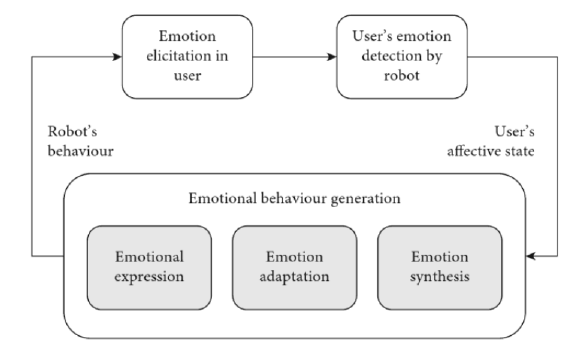
Figure 3. The Affective Loop, illustrated by Paiva et al. [48]. ©Oxford University